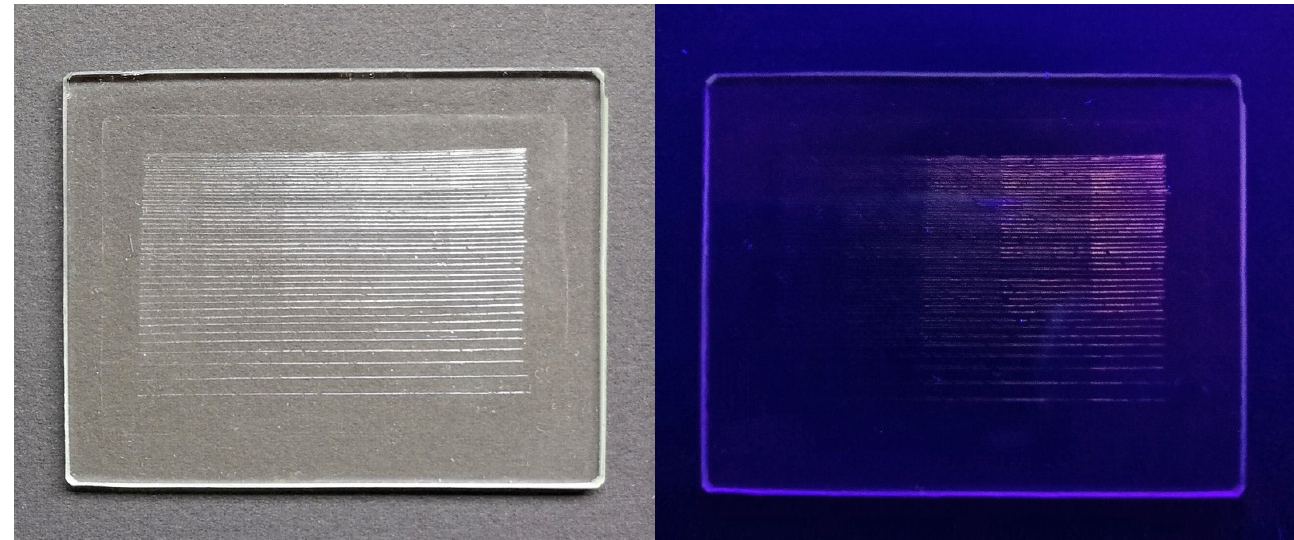
Figure 5. Line etching with sodalite zeolite composite, transfer print on glass. Sample viewed with visible light ( left ), sample viewed with UV light ( right ). Author’s photos. Figure created by